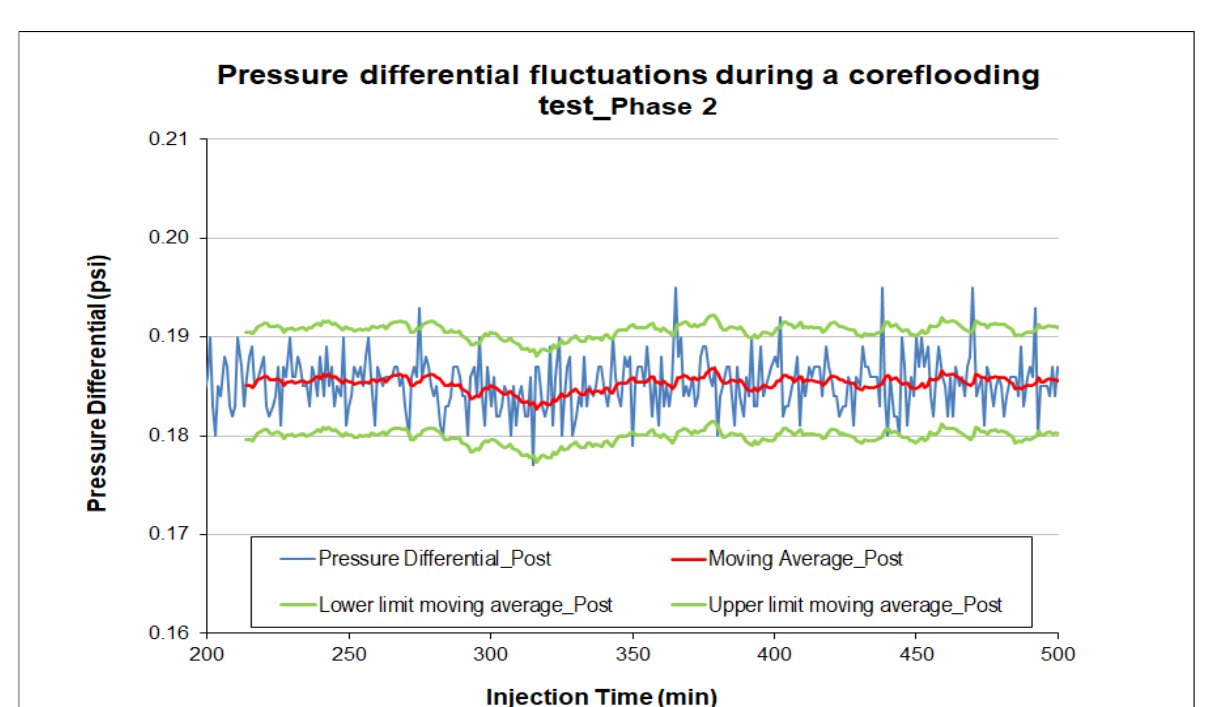
Figure 11: Fluctuations in the pressure differential data after making the modifications in the experimental protocol (Phase 2). Source: Authors,